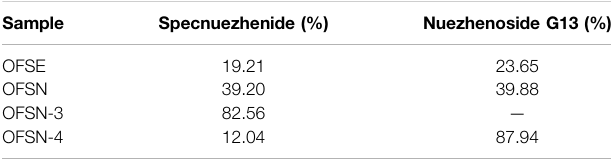
TABLE 7 | The percentage contents of Specnuezhenide and Nuezhenoside G13 in OFSE, OFSN, OFSN-3, and OFSN-4. Sample Specnuezhenide (%)